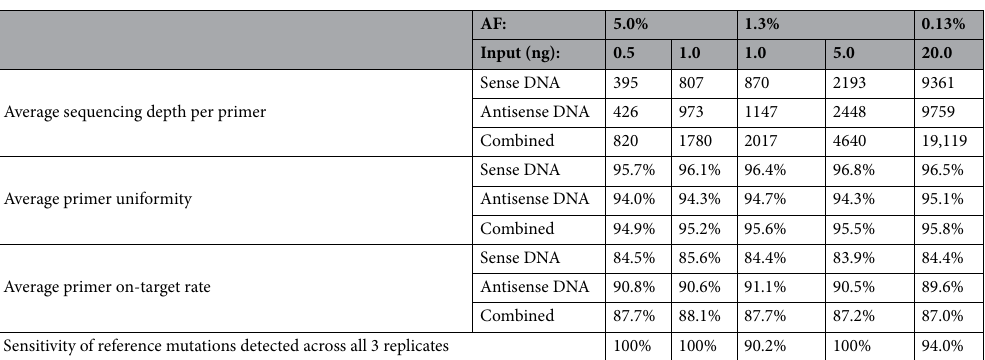
Table 1. Sequencing quality and sensitivity of ATOM-Seq SNV protocol on reference samples. Genome mapping rates were > 99% for all samples.